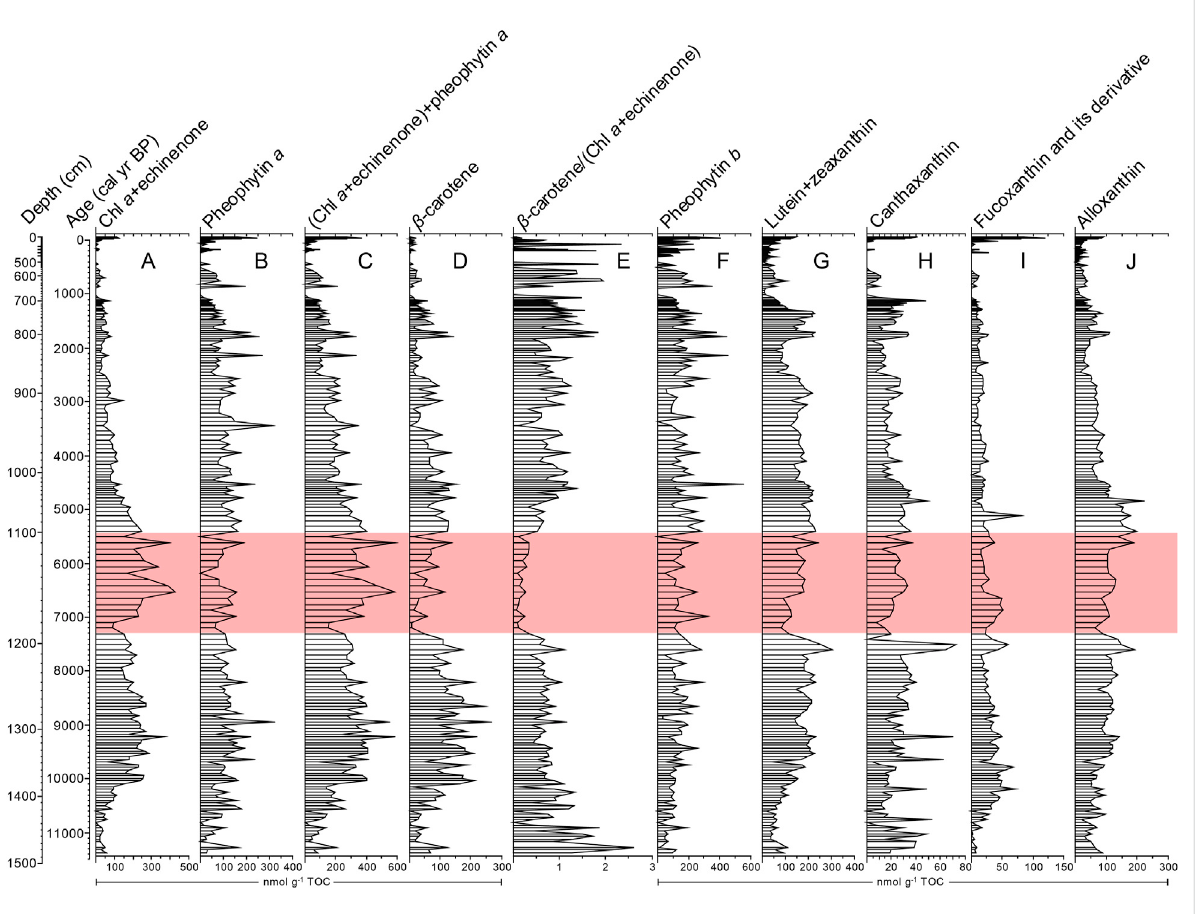
FIGURE 3 Pigments from the Lake Mayinghai core MYH14B. The pink bar indicates the mid-Holocene period with a distinctly low β -carotene to chlorophyll a + echinenone